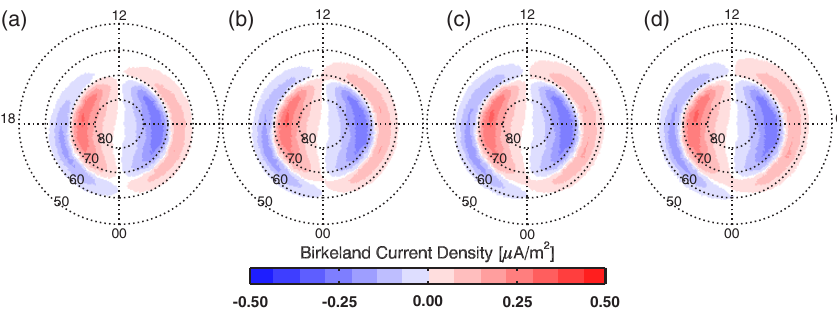
Fig. 2. Distributions of the upward (red) and downward (blue) Birkeland current density from the SWMF model with RCM coupling (a) one, (b) two, (c) three, and (d) four hours of real time into the simulation of nominal southward IMF conditions.